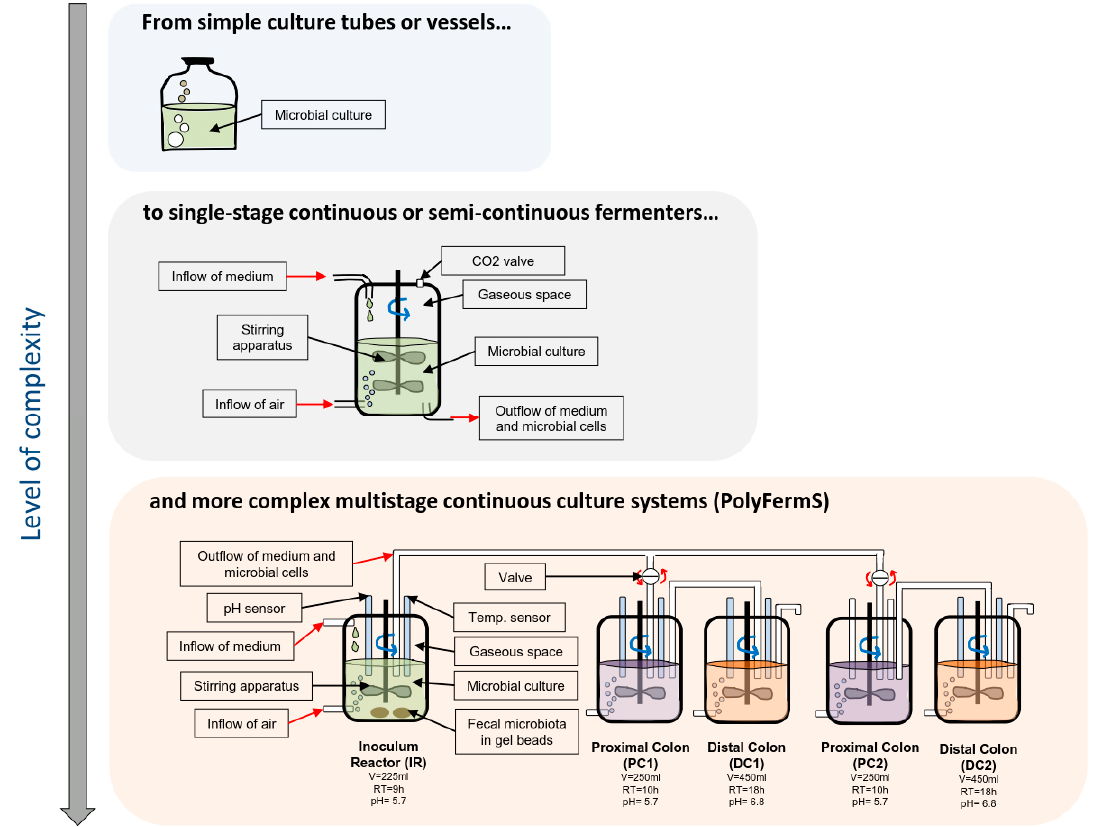
Figure 1. Schematic representation of the culture systems developed to analyze the microbiota ecosystems.